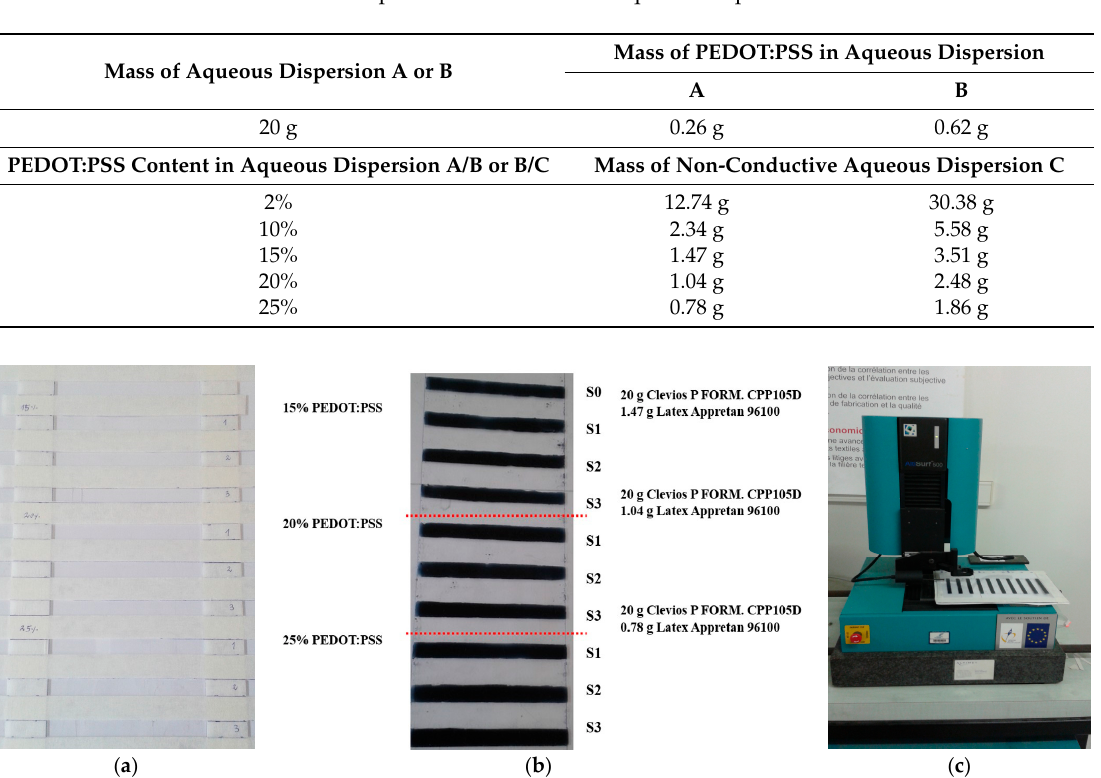
Table 5. Preparation of PEDOT:PSS aqueous dispersions.